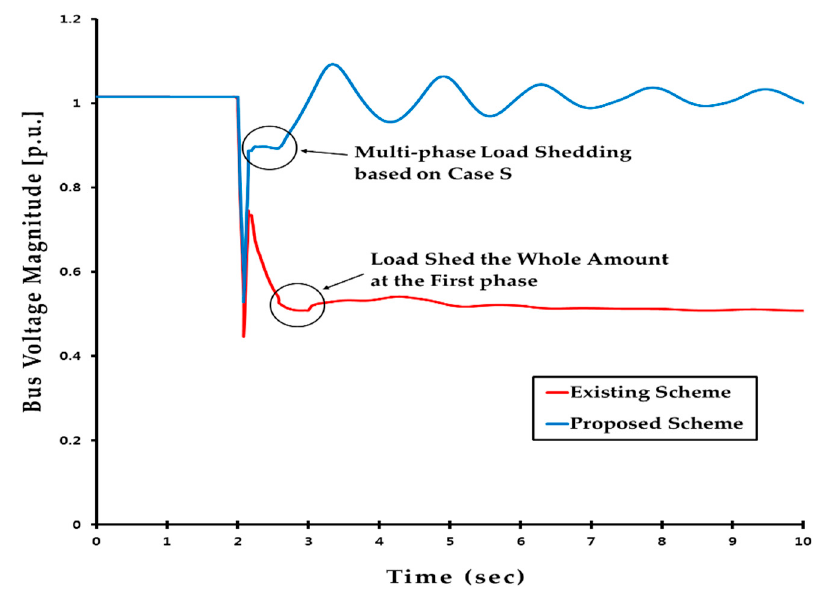
Figure 8. Comparison results of bus voltage recovery for existing scheme and proposed scheme.